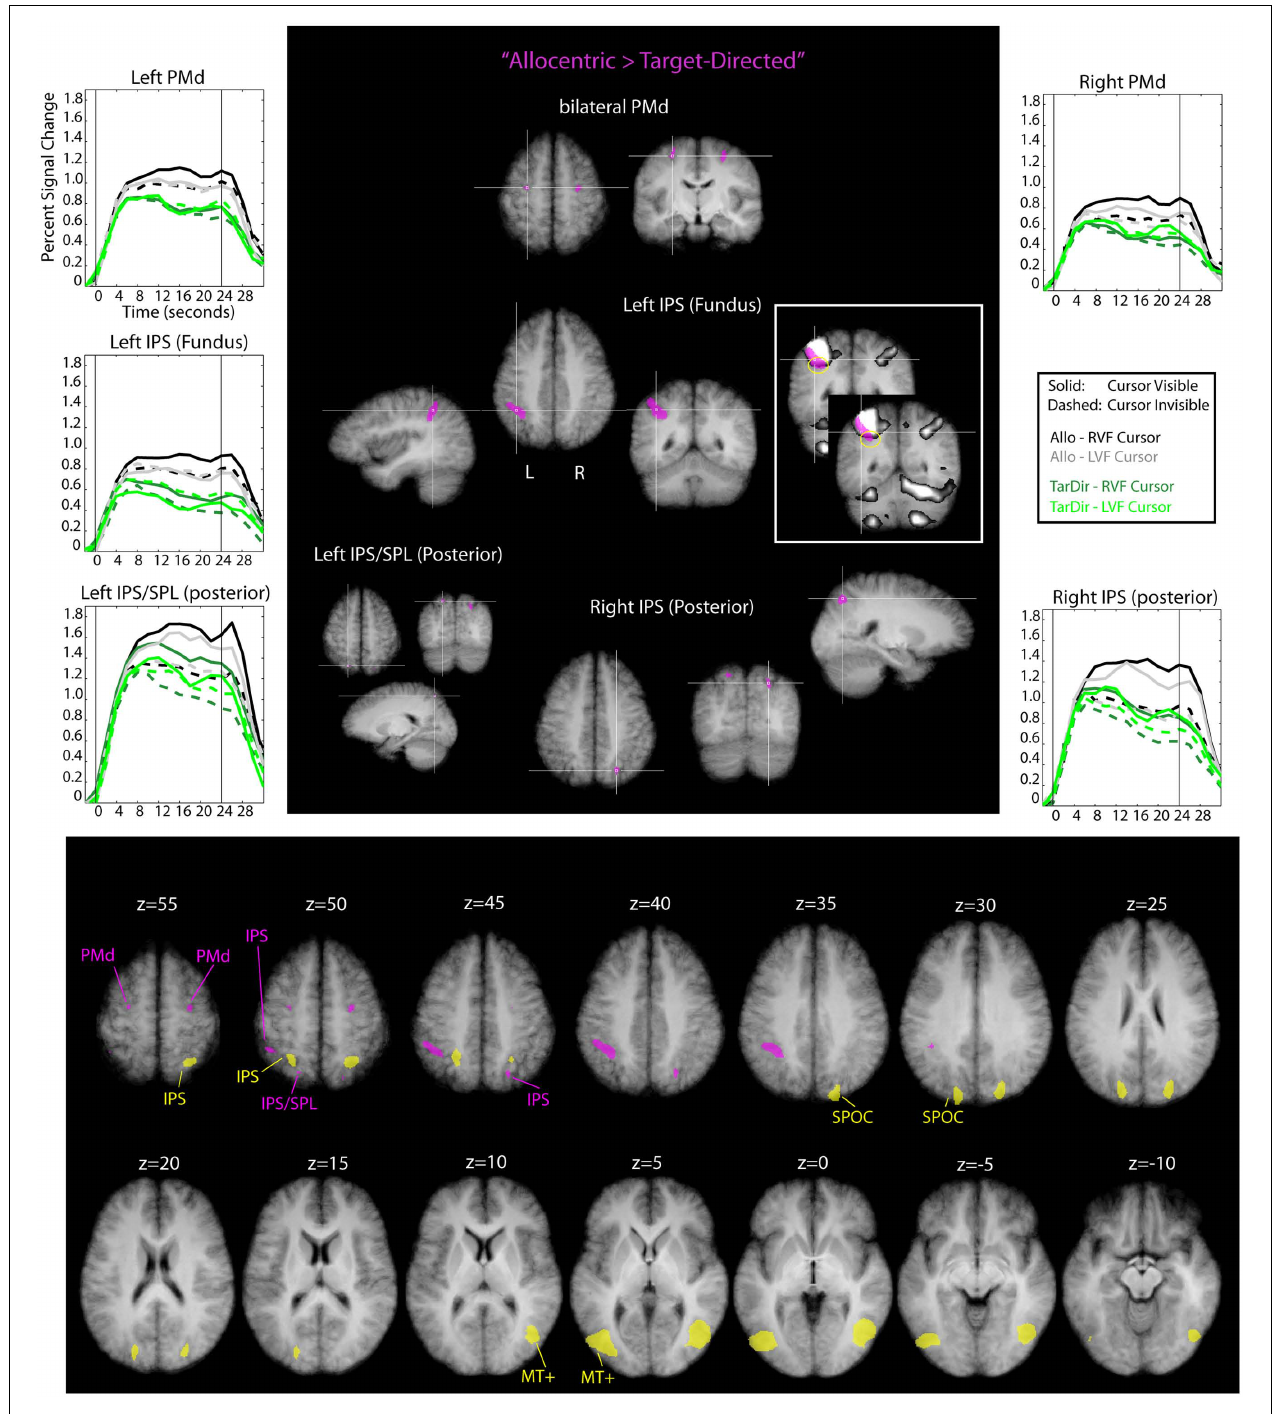
posterior superior parietal cortex (SPL). Stereotactic coordinates of activation foci are provided in Table 3 . Insets illustrate the degree of overlap between “allocentric areas” and the “shared sensory–motor network” (gray). No insets are provided for areas overlapped entirely by the “shared sensorimotor network.” Event related averages of regions depicted in magenta are shown as well. Lower panel: slice views to illustrate relative arrangement of “visual feedback” (yellow) and “allocentric” (magenta) brain areas. It is evident that “visual feedback” and “allocentric” areas do not